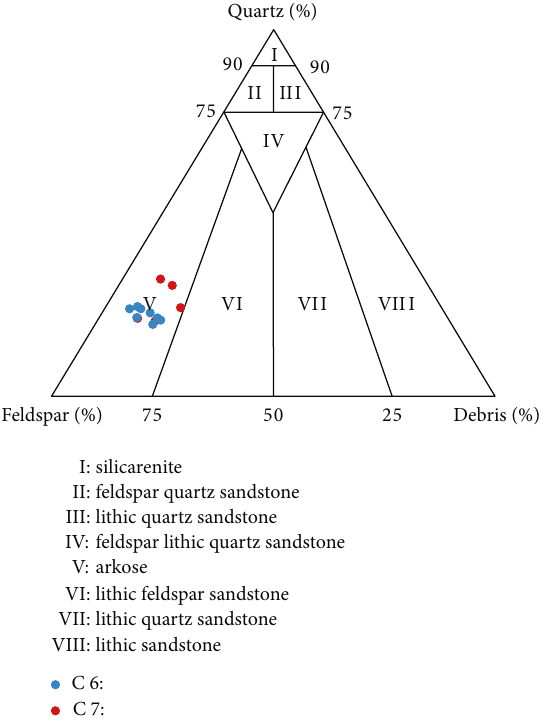
Figure 1: Rock type classi fi cation of C 6 and C 7